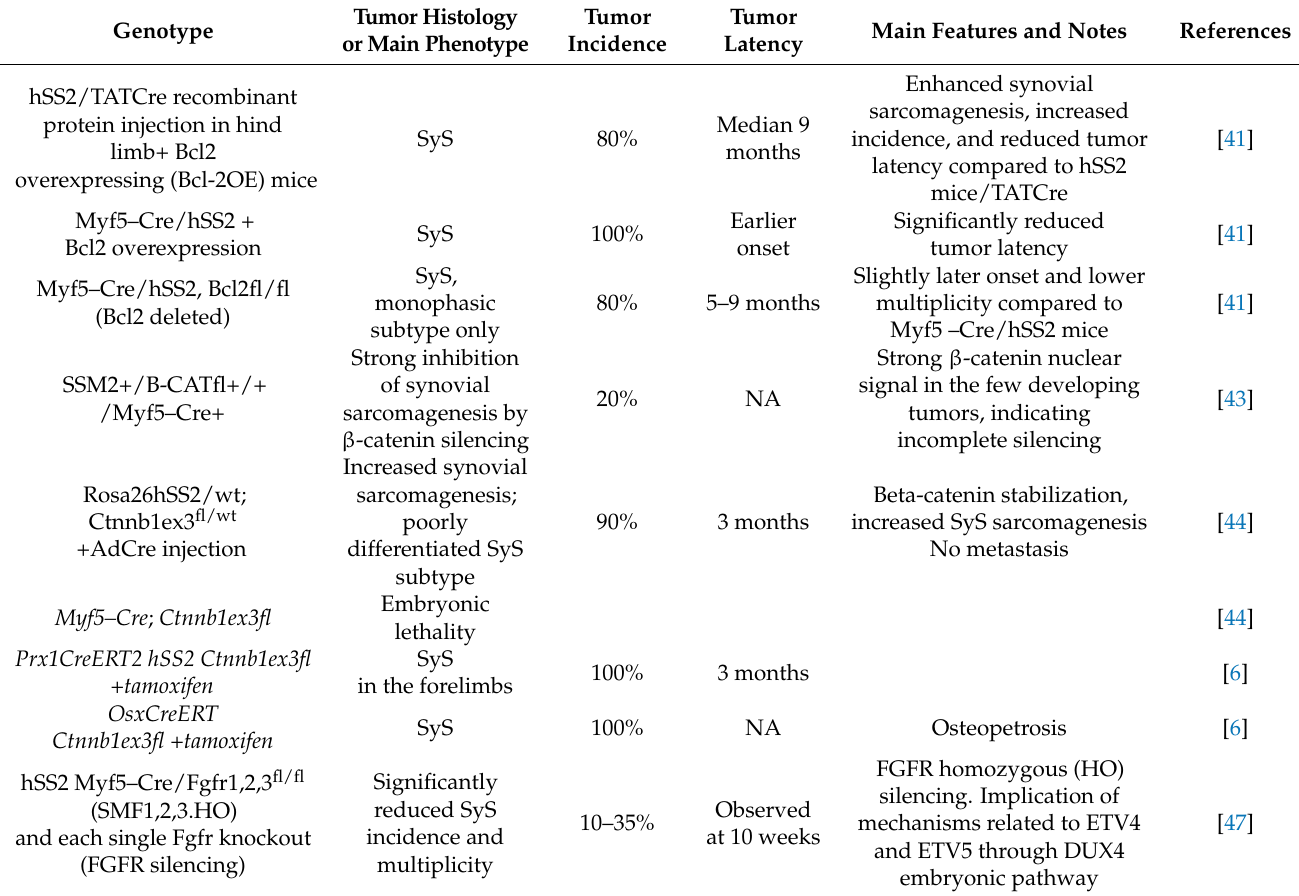
Table 2. Combination of conditional SyS mouse models and oncogene